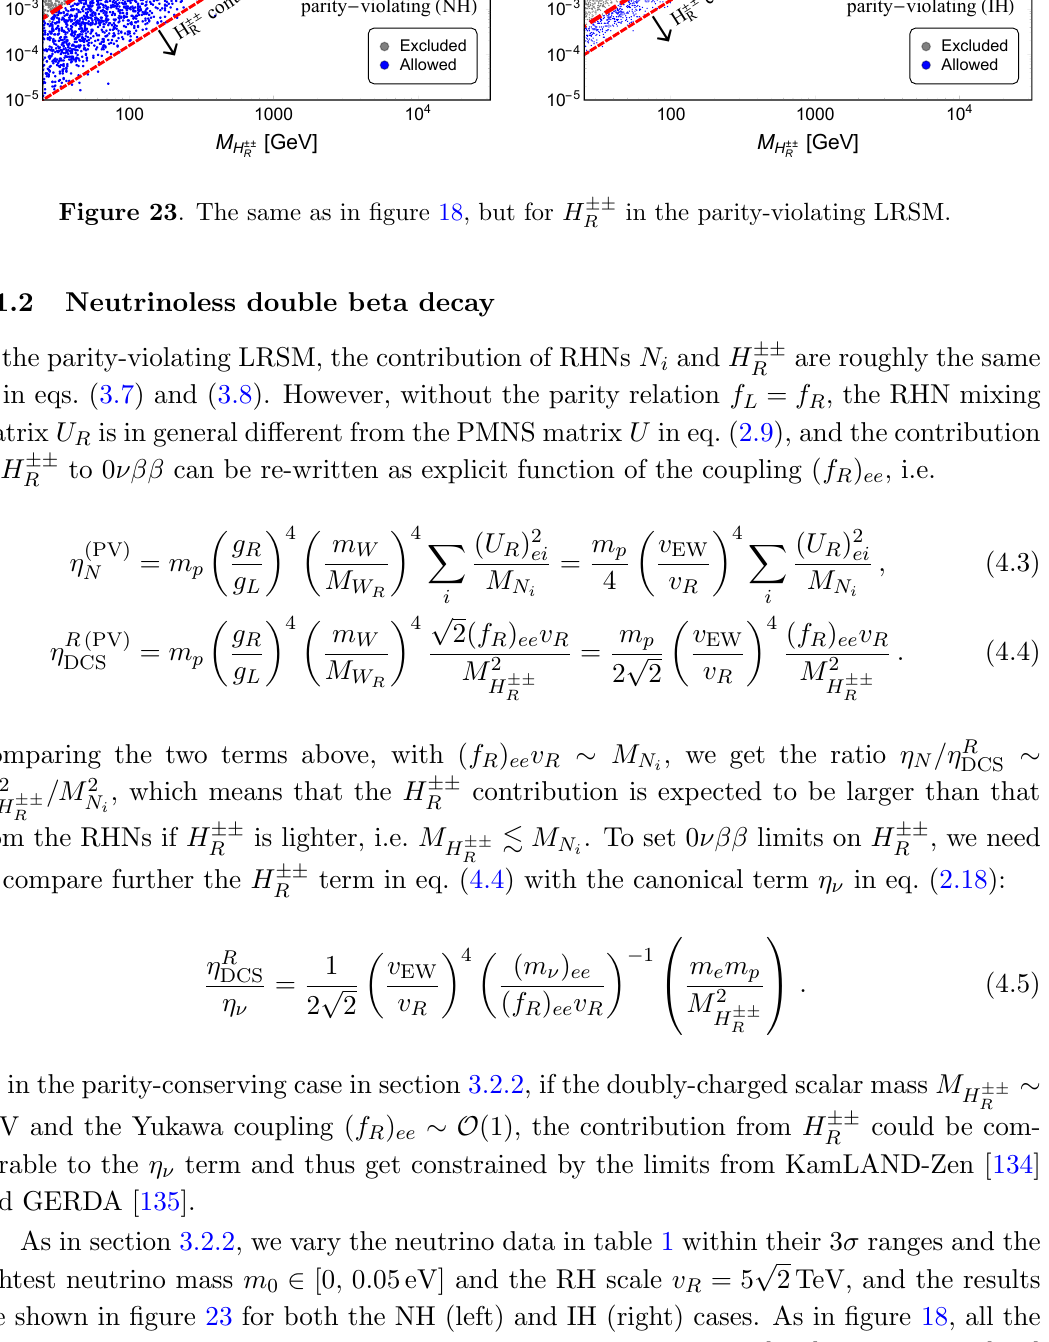
Figure 23 . The same as in (cid:12)gure 18, but for H (cid:6)(cid:6)